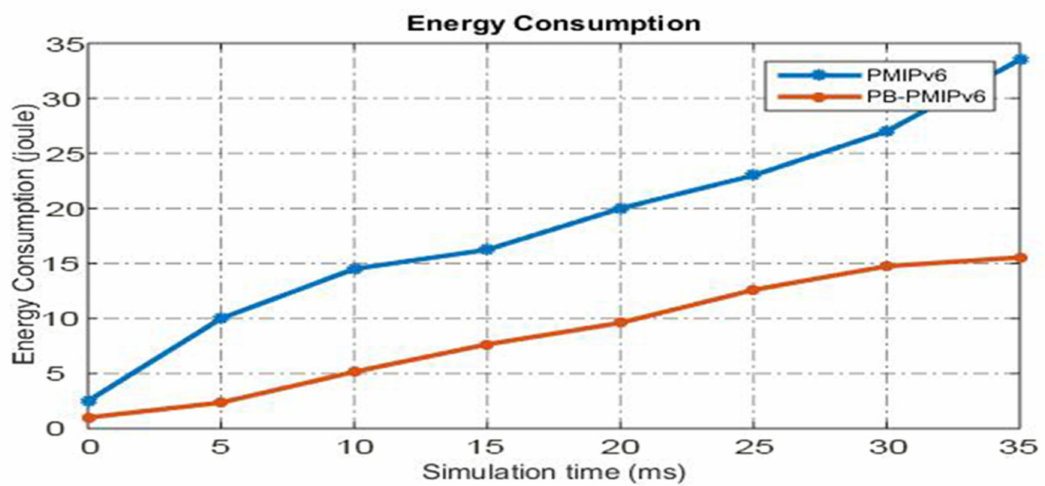
Figure 13. Comparison of energy